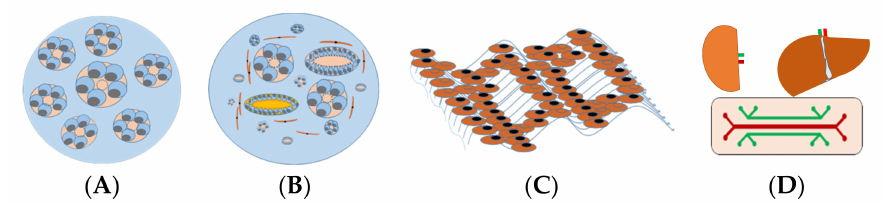
Figure 1. In vitro 3D kidney models for predicting nephrotoxicity. ( A ) Renal spheroids are often considered as RPTEC embedded in hydrogel to form hollow spherical cysts with an apical membrane facing the renal tubular lumen. ( B ) Organoids consist of multiple cells, different types of renal tubular, endothelial, and interstitial cells that self-organize in response to developmental cues and overcome the cellular simplicity of 2D cultures. ( C ) Three-dimensional (3D)-engineered kidney tissue consists of various renal cells with ECM as a complex and highly charged network (i.e., collagen, elastin, laminin, and glycoproteins), providing a 3D structure for the spatial organization of cells. ( D ) A kidney-liver-on-a-chip that comprises a perfusable, convoluted 3D renal tubule, and liver cells within the ECM enable fluid flow and the administration of test compounds to the apical surface of the